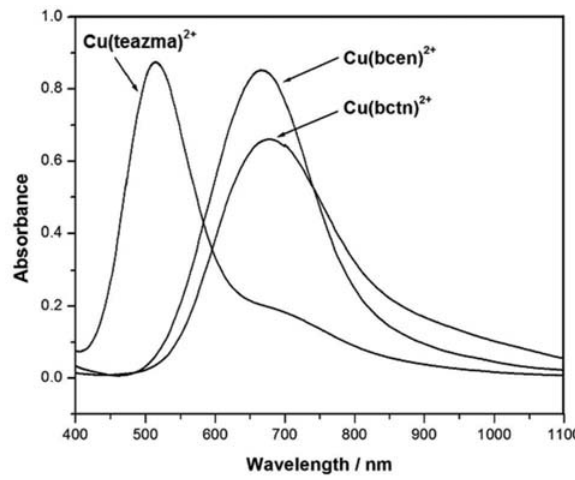
Fig.1. Visible spectra of Cu [ (teazma) ] (ClO Cu(bctn)(NO